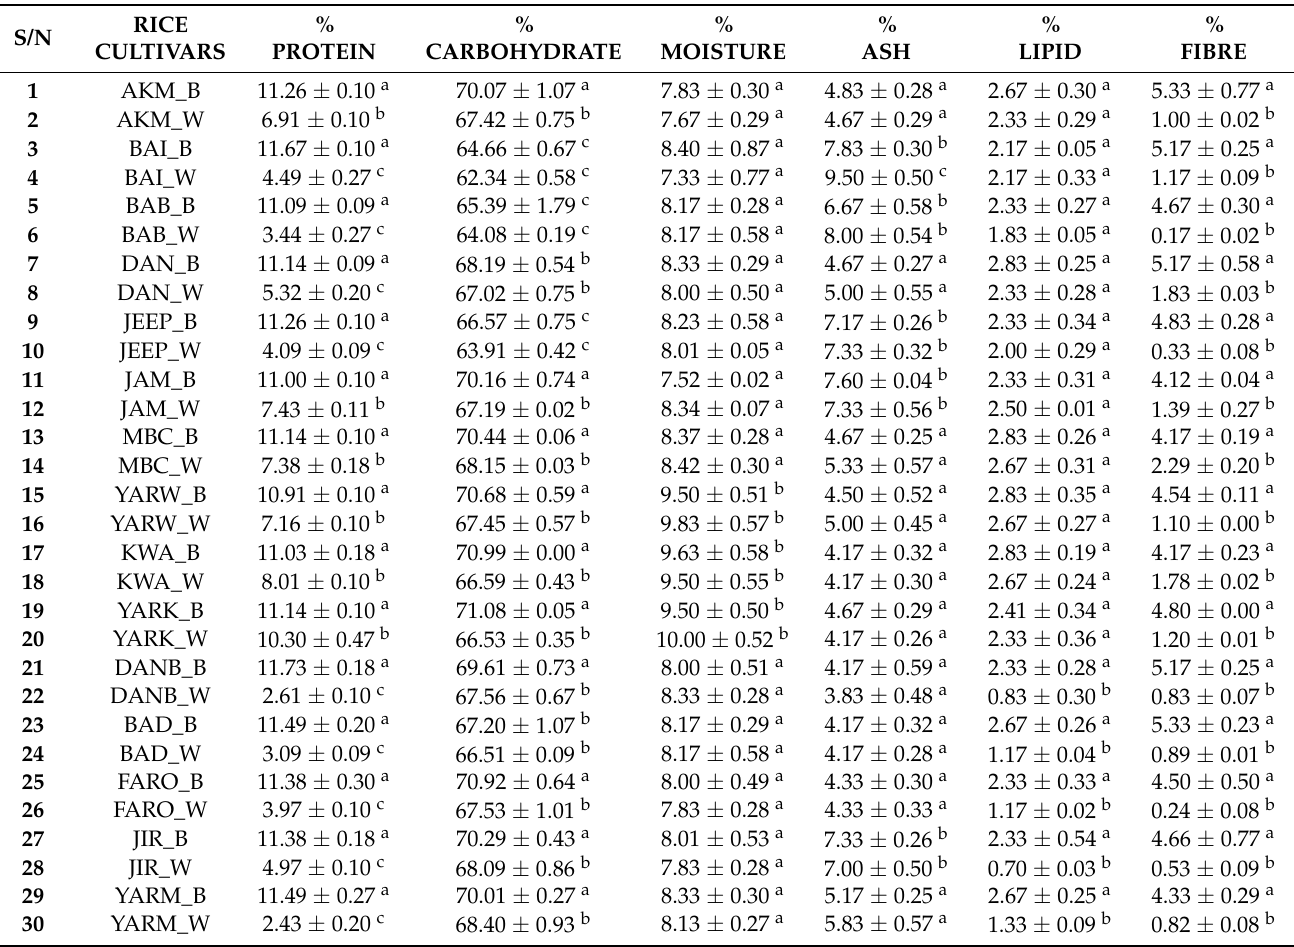
Table 1. Proximate composition and crude fibre content of rice cultivars in dry